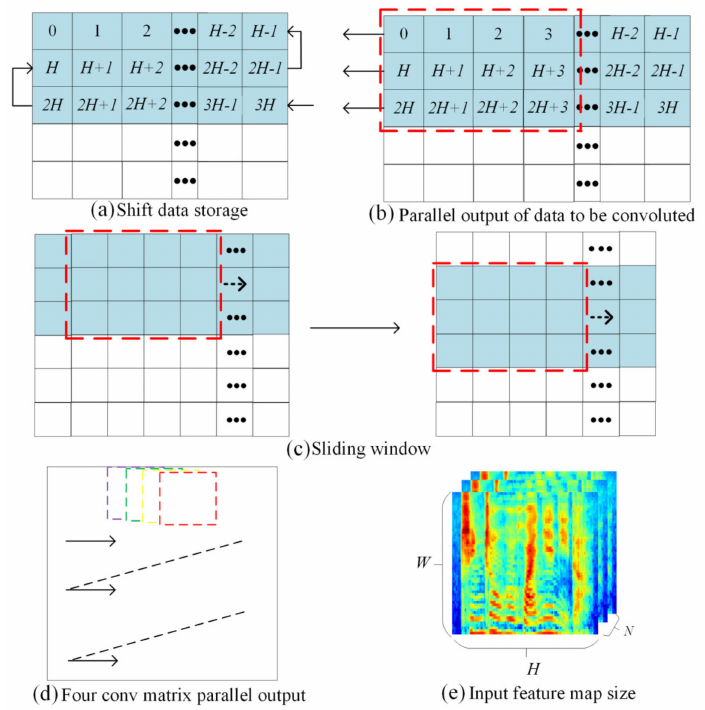
Figure 4. Convolution four-matrix parallel fetch.